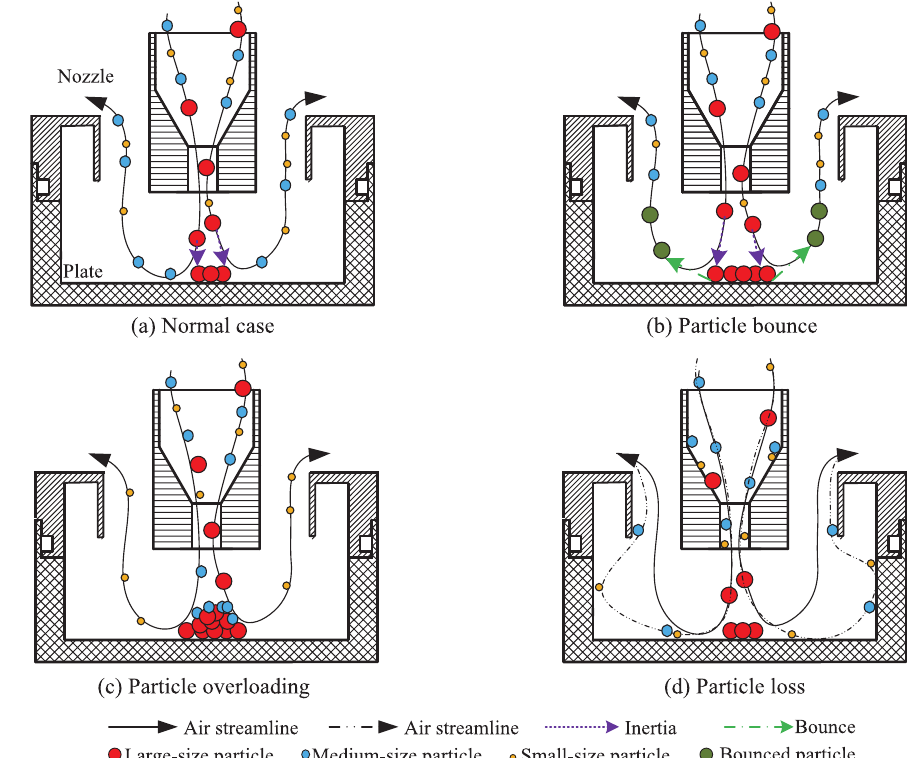
Fig. 1 Inertial impactor problems (a) normal case (b) particle bounce, (c) particle overloading, and (d) particle